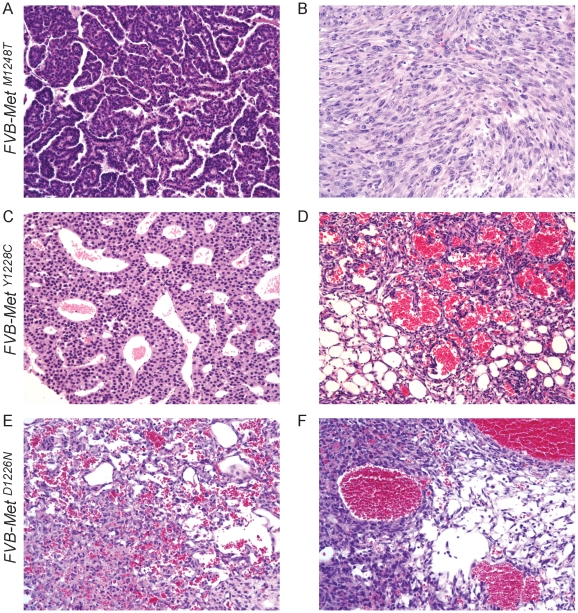
Spectrum of tumors observed in Met mutants.A) A bronchial alveolar adenocarcinoma and B) a histiocytic sarcoma in a FVB-MetM1248T mouse. C) A plasmacytoma and D) a sarcoma in a FVB-MetY1228C mouse. E and F) Hemangiosarcomas observed in the mammary pads of two individual FVB-MetD1226N mice. All H&E images were taken at 200× magnification.